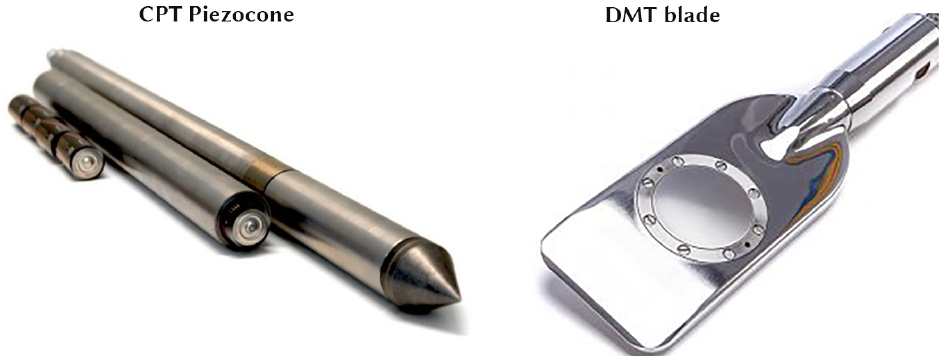
Figure 3. CPT piezocone cone and flat dilatometer DMT blade.